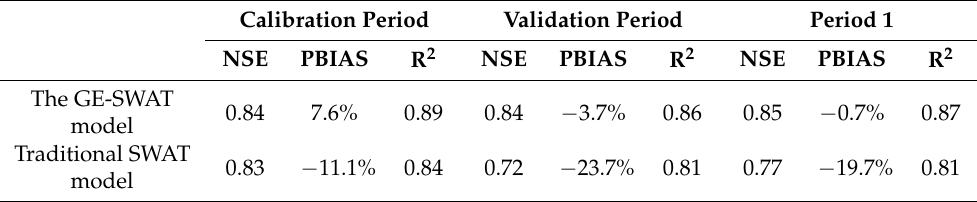
Table 4. The changing characteristics of hydrometeorological elements in a seasonal scale.